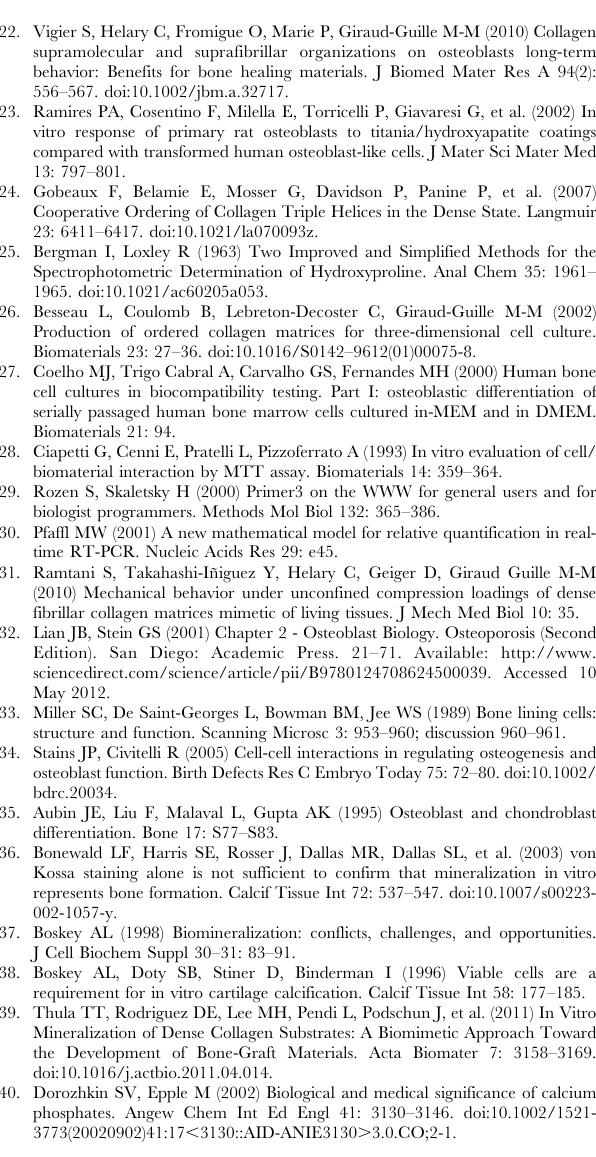
Figure S1 SEM observations of osteoblasts seeded on dense collagen matrices. Figure S2 Thermogravimetric analyses of matrices at D28 and D60. Table S1 Primer sequences used for PCR and real-time PCR analysis of the eleven genes, and amplicon lengths.